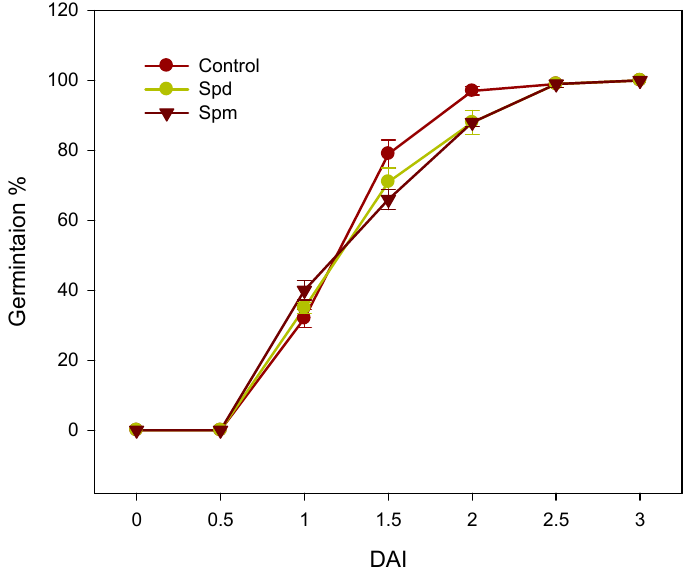
Figure 1. Germination percentage of the soybean seeds with or without the seed treatment with spermidine (Spd) or spermine (Spm). Data are the means ± SE, n = 5, where n refers to a batch of 20 seeds. DAI, days after imbibition. 20 seeds. DAI, days after